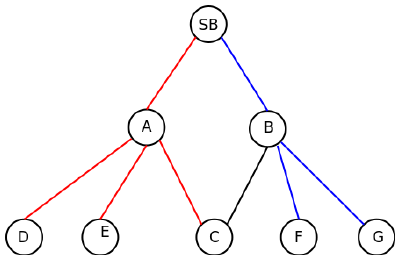
Figure 3. Slot allocation: Situation